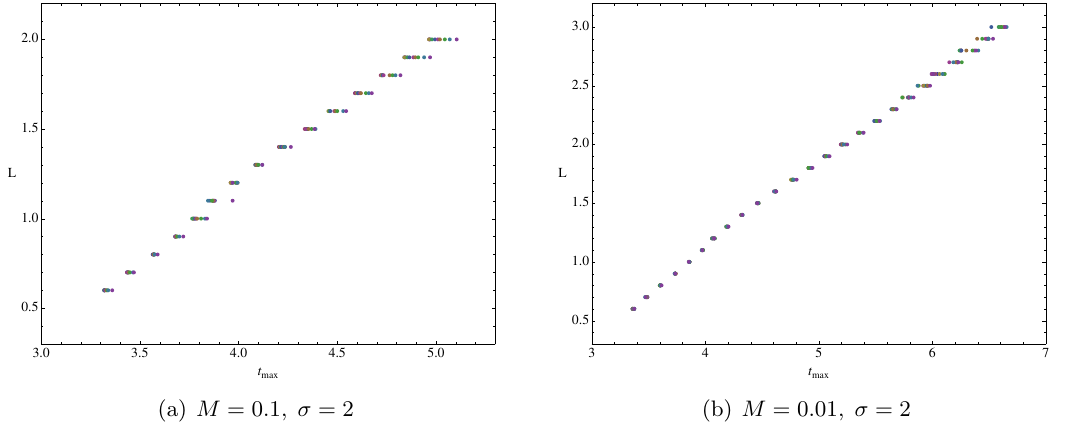
Figure 1 . The curves traced by the maximum of (cid:1) S A ( t ) in the L (cid:0) t plane. Note that all charged con(cid:12)gurations have been included in the same (cid:12)gure to illustrate the weak dependence of the lightcone behaviour with respect to charge. In both cases, the early-time velocities are found in close proximity to the butter(cid:13)y velocity ( v E 2 [0 : 8 ; 0 : 9]), whereas the late-time velocities are found within v E 2 [0 : 65 ; 0 : 71], an interval containing various velocities of interest.